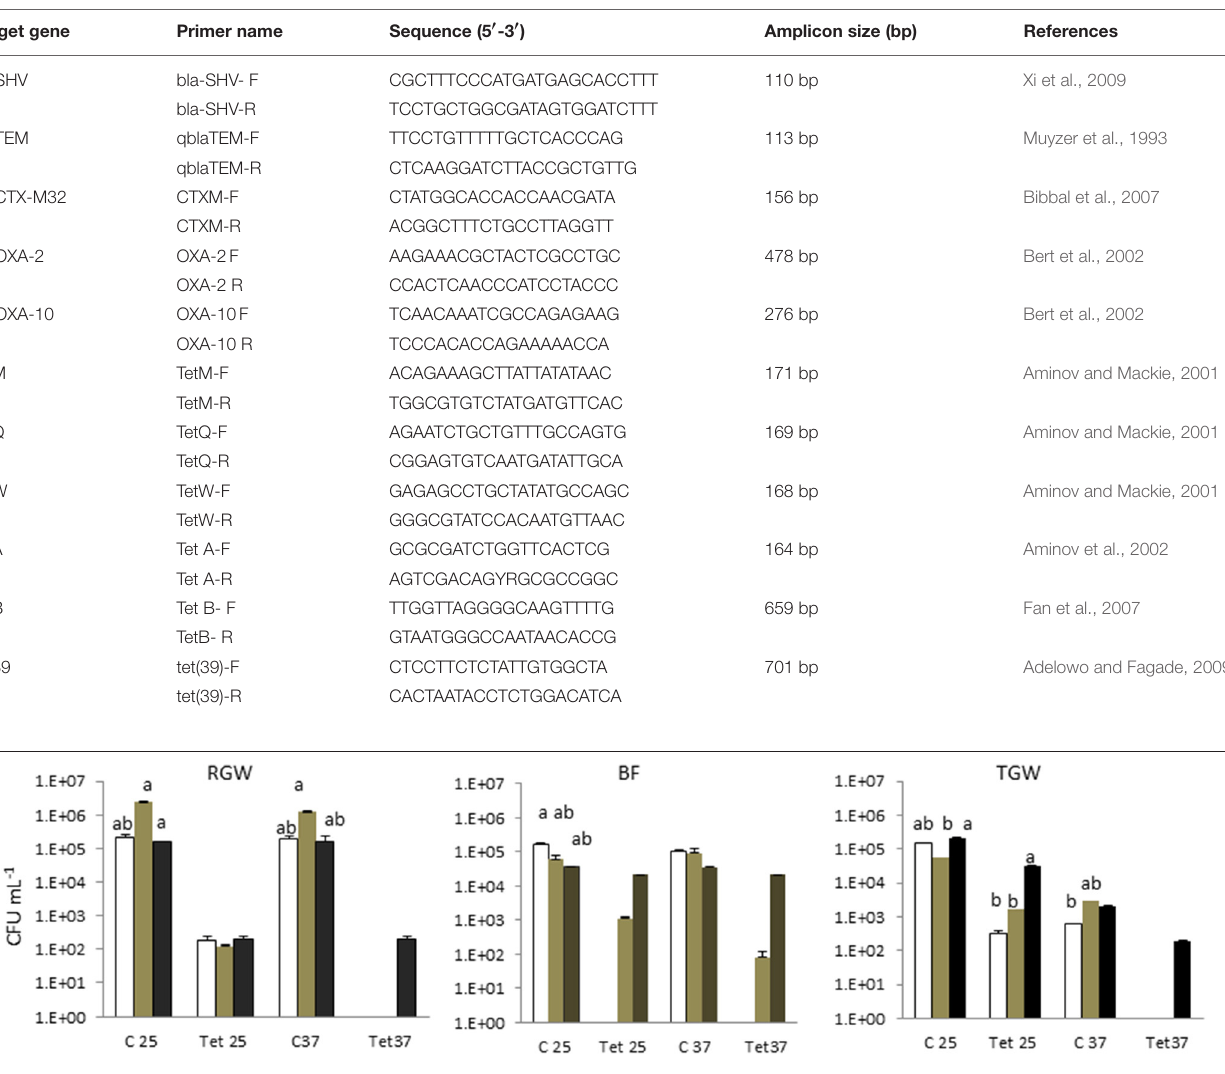
FIGURE 1 | Total bacterial count (TBC) and tetracycline (tet)-resistant bacterial count (TRBC) in the three examined systems in all sampling locations.